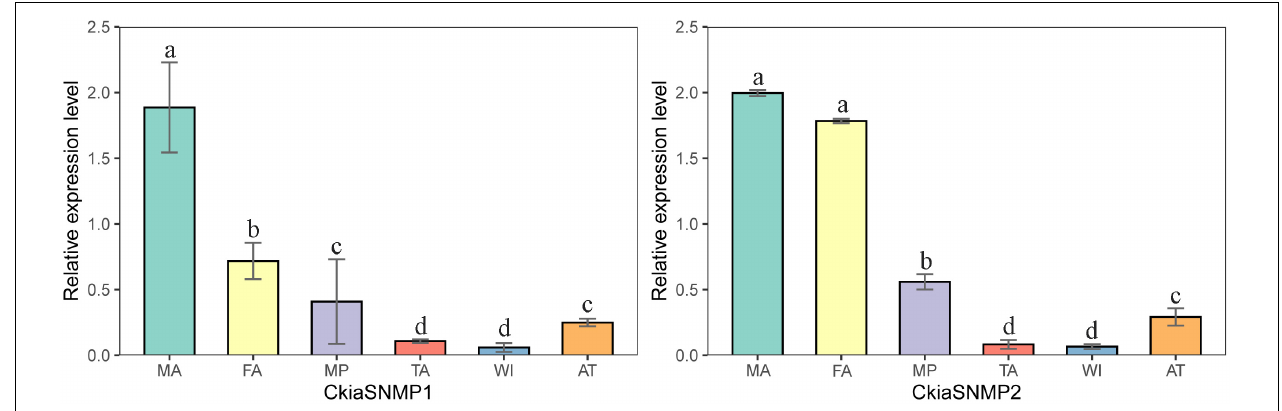
FIGURE 11 | Relative expression levels of SNMPs in different tissues of C. kiangsu as measured by RT-qPCR. FA, female antennae; MA, male antennae; MP, maxillary palps; TA, tarsi; WI, wings; AT, thoraxes-abdomens. The bar represents standard error and the different small letters above each bar indicate significant differences ( P < 0.05).